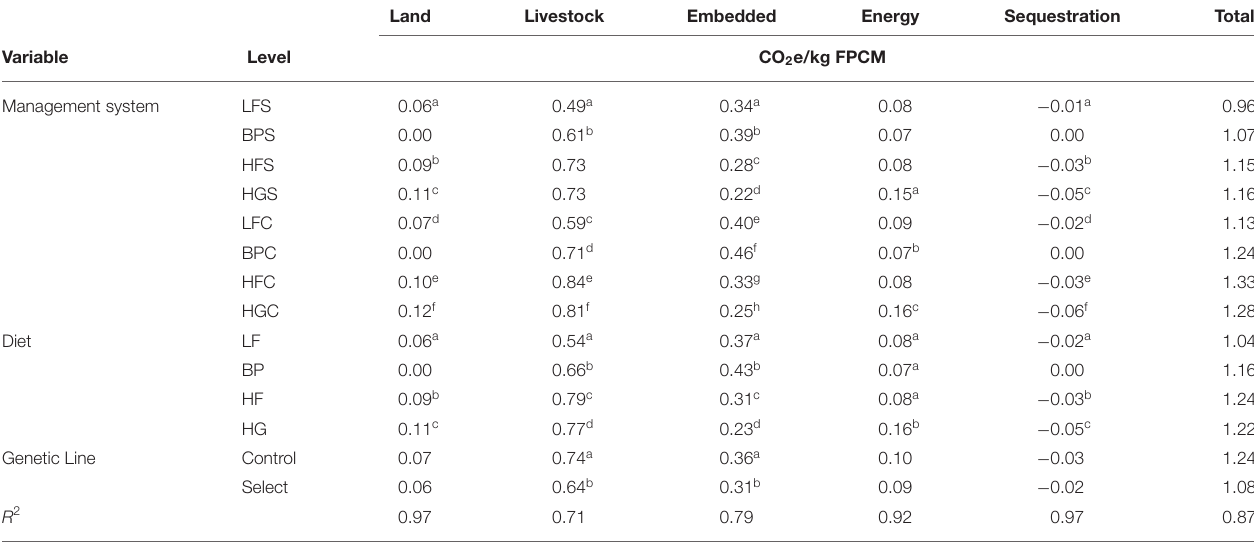
TABLE 7 | Least square means (lsm) of dairy system GHG’s by emission type.